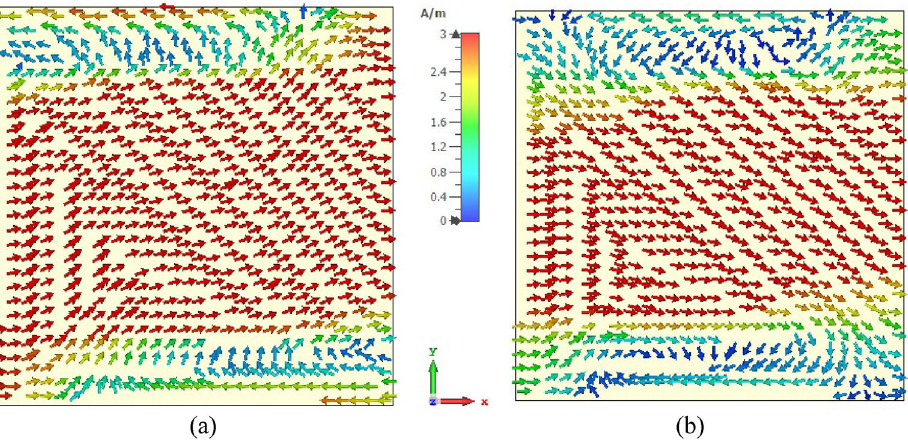
Figure 21. Copper backplane surface current distribution at ( a ) 3.3 GHz and ( b ) 5.7 GHz for absorber resonator (CST STUDIO SUITE 2019, https:// www. 3ds. com/ produ cts- servi ces/ simul ia/ produ cts/ cst- studio- suite) 39 .